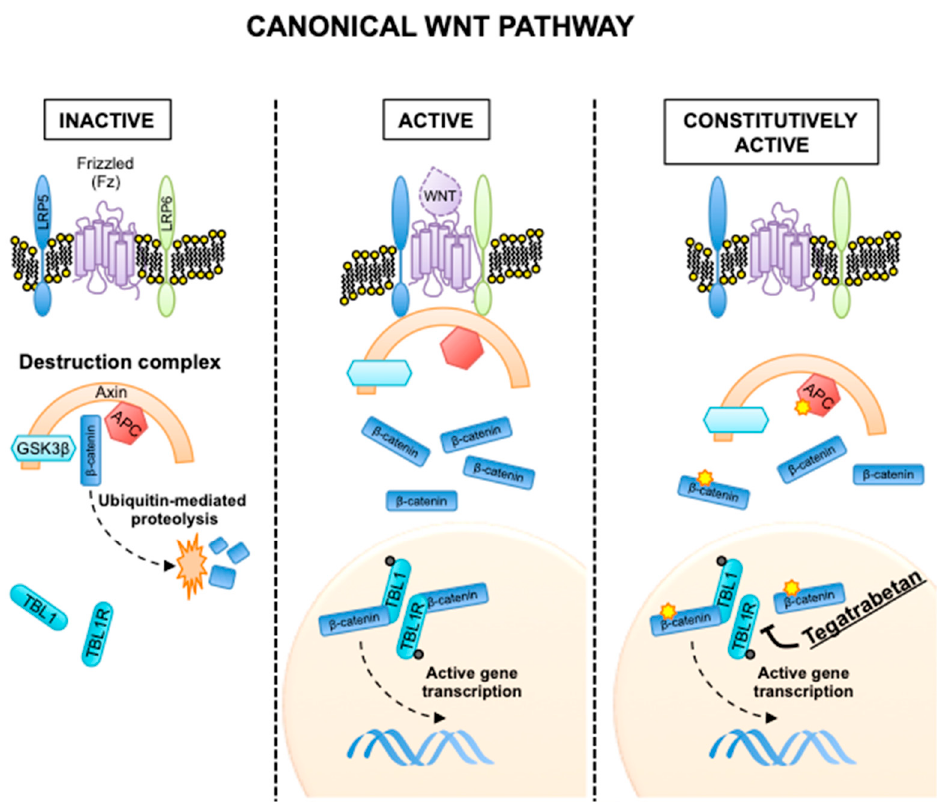
Figure 1. Canonical Wnt pathway in its inactive, active and constitutively active states. In the constitutively active state, the yellow stars indicate activating mutations in the β -catenin gene ( CTNNB1 ) and inactivating mutations in APC. Mechanism of action of tegatrabetan is shown. In sporadic DT, recurrent mutations in one of three major hotspots in the exon 3 (T41A, S45F and S45P) of the β -catenin gene ( CTNNB1 ) disrupt the interaction between β -catenin and APC [10]. In FAP-associated DT, inactivating mutations in APC with subsequent loss of the wild-type allele results in the same defective interaction. This ultimately results in a slower degradation of β -catenin